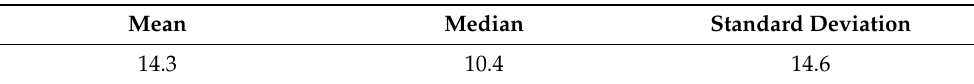
Table 3. Mean, median, and standard deviation evaluated of organic HAP EF of the dataset expressed in g/ton of crude oil processed.